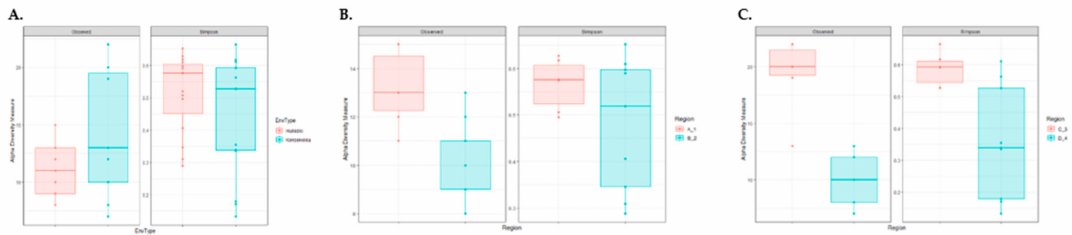
Figure 3. Alpha-diversity boxplots for table olive’s bacterial families of ( A ) cultivar Halkidiki and Konservolia, ( B ) cultivar Halkidiki from Halkidiki (A_1) and Kavala (B_2) regions, and ( C ) cultivar Konservolia from Magnesia (C_3) and Fthiotida (C_4) regions based on observed and Simpson